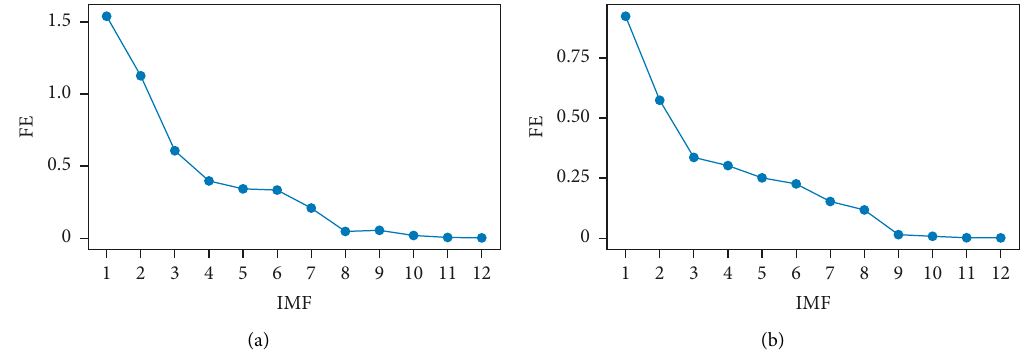
Figure 8: IMF FE of (a) 717490 and (b) 718462.